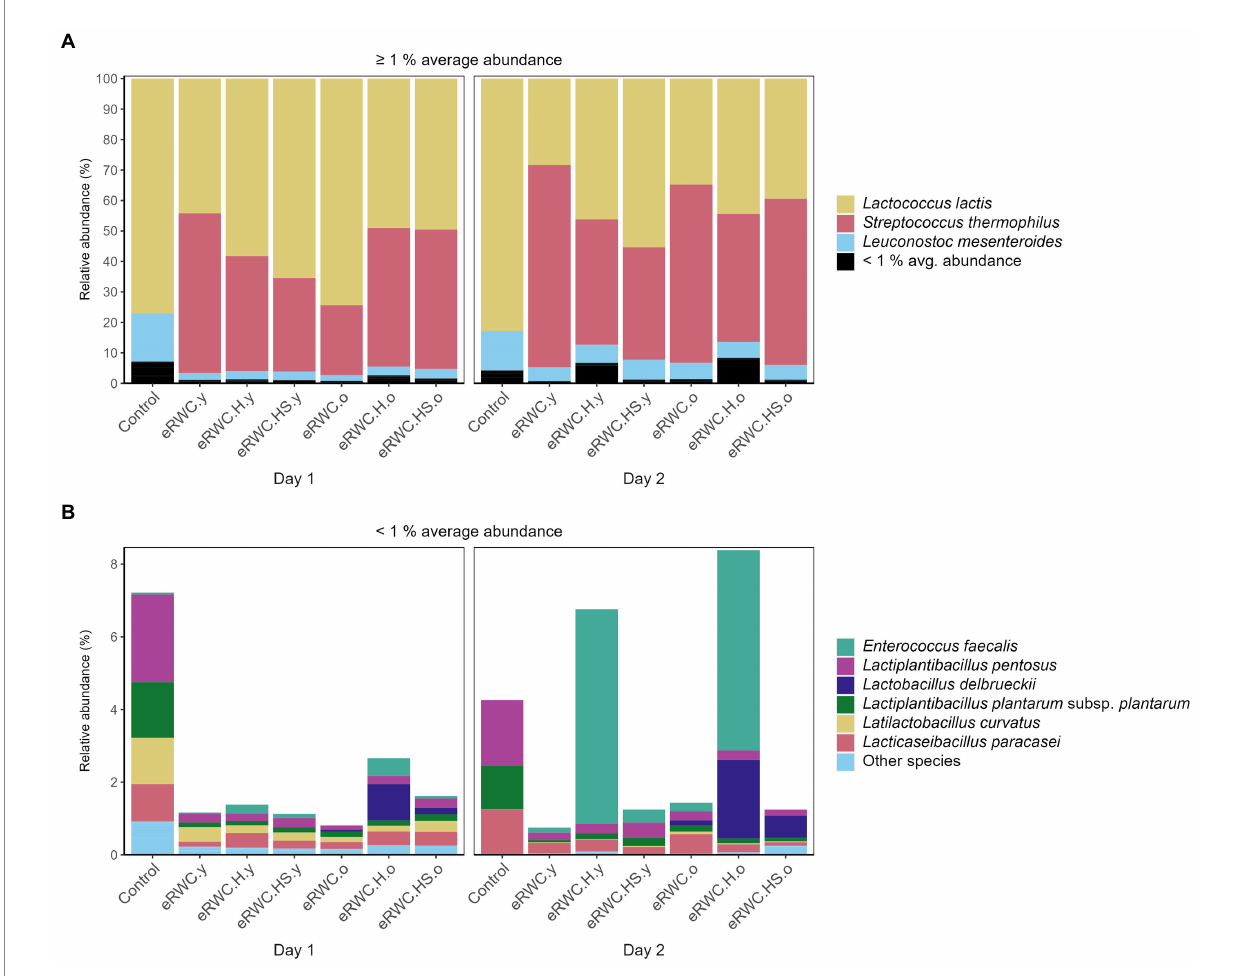
FIGURE 6 NGS results of 120 d ripened cheese produced with the different eRWCs: stacked bar plot of species’ relative abundance (%). (A) Species with and average abundance ≥ 1%. (B) Species with and average abundance <1%. Refer to Figure 1 for samples’ abbreviation; the two samples’ replicates (day 1 and day 2) are